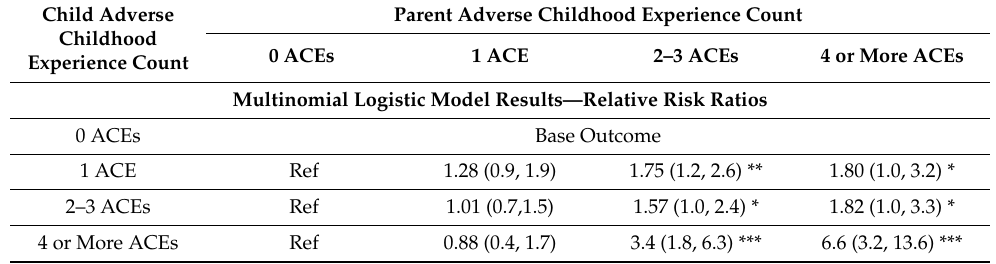
Table A1. Differences in Adjusted Relative Risk Ratio of Adult Child ACE Count Category by Highest of Either Parent’s Adverse Childhood Experience Count—Results of the Multinomial Model Results Used to Estimate Predicted Probabilities in Table 3 Above.